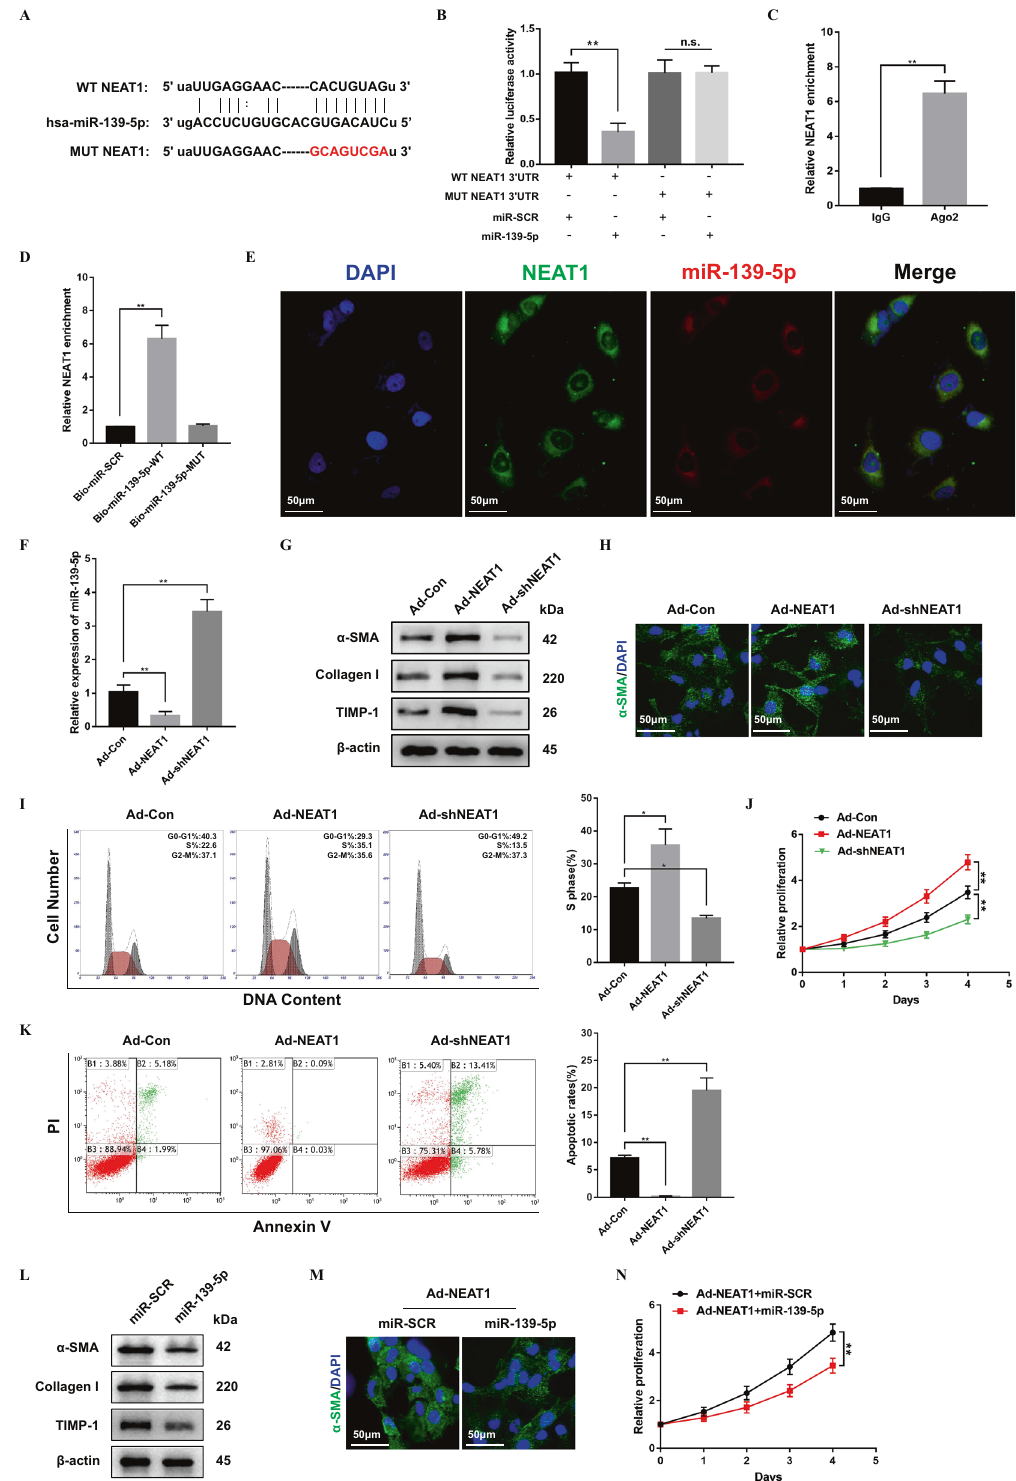
NEAT1 and miR-139-5p. Then, we performed luciferase reporter assay to verify that miR-139-5p was a target of NEAT1 (Fig. 2A). LX- 2 cells were transfected with miR-139-5p mimics and the luciferase reporter plasmids, which contained the wild type of NEAT1 or the mutant type of NEAT1. The result showed